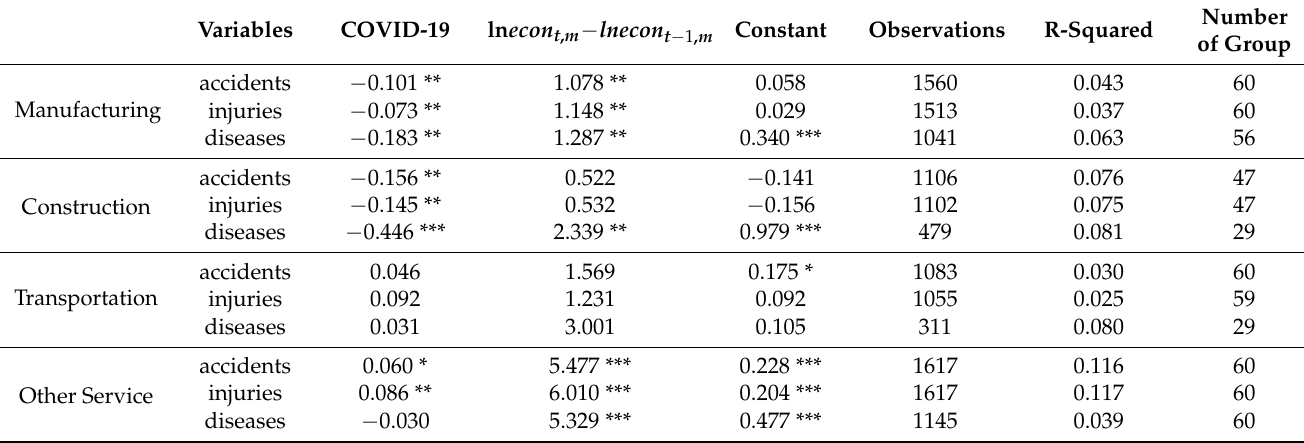
Table 6. Estimation results of fixed effects models by industry.